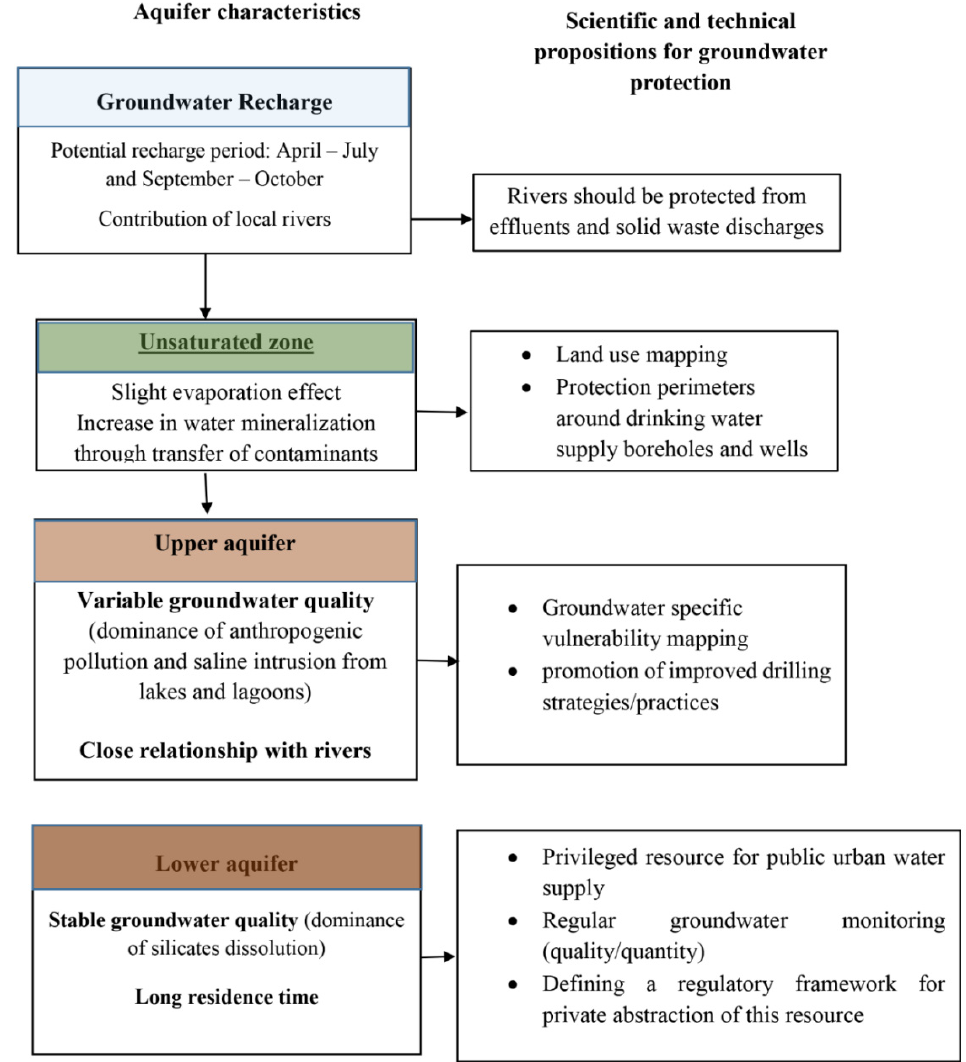
Figure 10. Main hydrogeological characteristics and proposals to enhance the aquifer protection strategies.